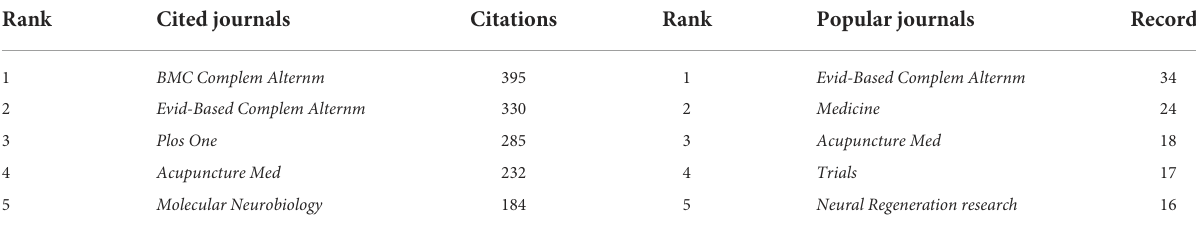
TABLE 2 Top five journals and cited journals related to acupuncture treatment of cognitive impairment.